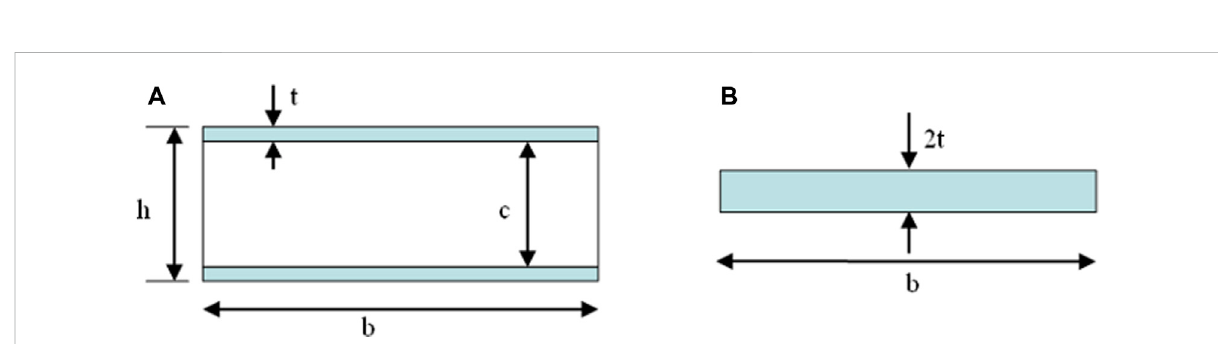
FIGURE 3 Cross section of (A) typical sandwich composite construction (B) monocoque